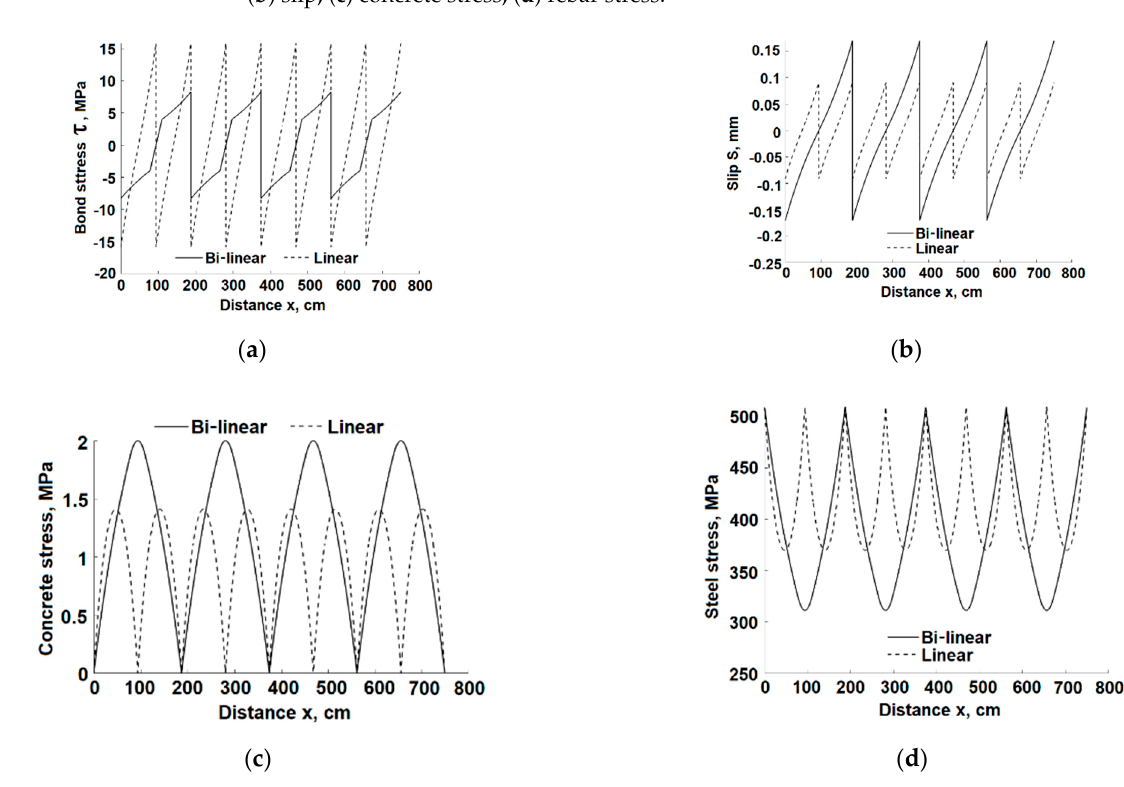
Figure 15. Slip and stresses distributions at the rebar yielding ( P = 40.00 kN). ( a ) bond stress; ( b ) slip; ( c ) concrete stress; ( d ) rebar stress.